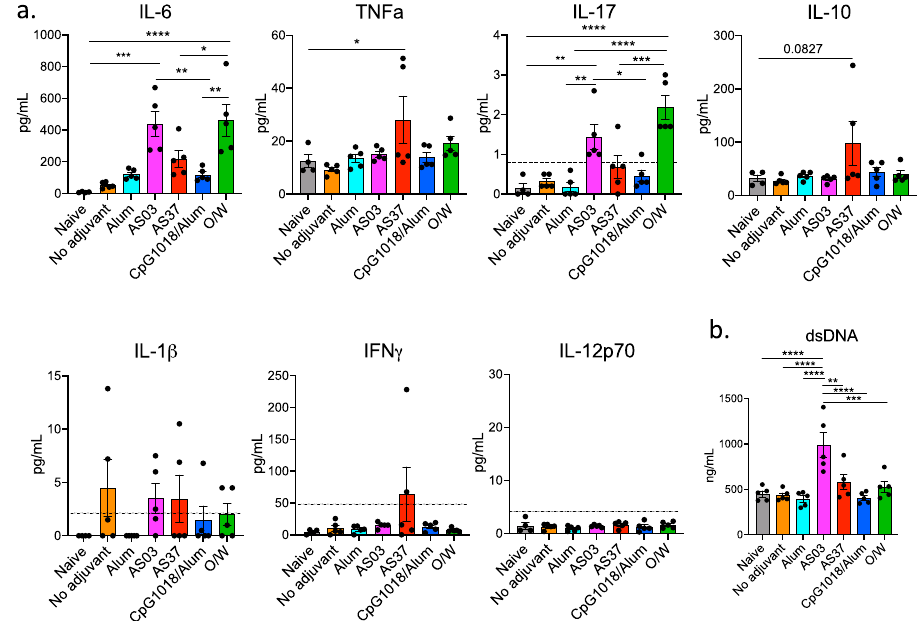
Fig. 6 Early cytokine responses following immunization with RBD-NP and adjuvants. a Cytokine measurement in serum of mice immunized with each adjuvant formulation at 2 h post-immunization. Serum cytokines analyzed by Simoa multiplex assay. Dashed lines indicate detection limit. If no dashed lines are present, all samples were above detection threshold. b Serum dsDNA analysis 24 h post- immunization with each adjuvant formulation. P -values: * denotes p < 0.0332, ** p < 0.0021, *** p < 0.0002, and **** p < 0.0001. Error bars indicate mean ± SEM in all